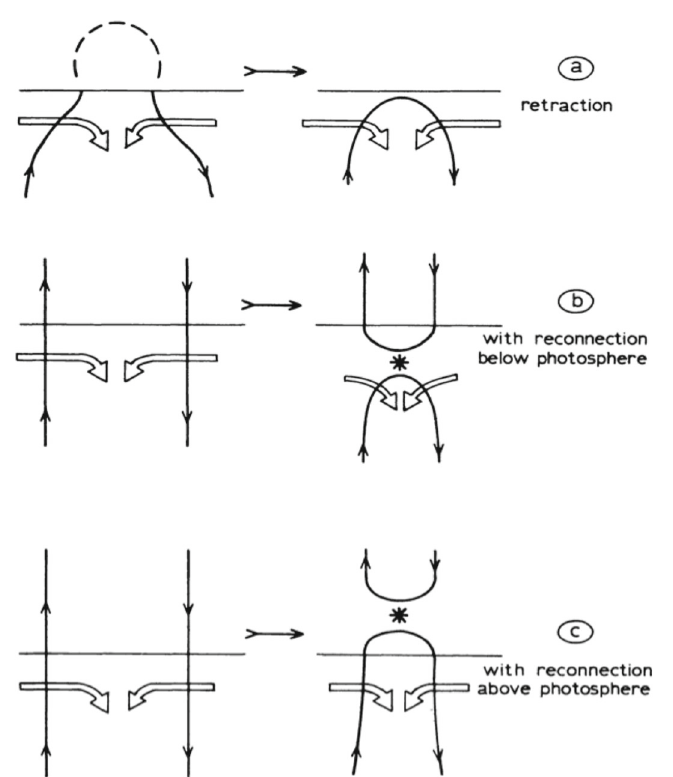
Fig. 22 Cancellation scenarios proposed by Zwaan (1987). Case ( a ) represents the retraction of existing field lines forming an Ω -loop. Cases ( b ) and ( c ) imply prior reconnection of unrelated field lines below ( b ) or above ( c ) the photosphere. After reconnection takes place, the flux is removed by the emergence of a U-loop or the submergence of an Ω -loop. Image reproduced with permission, copyright by Annual